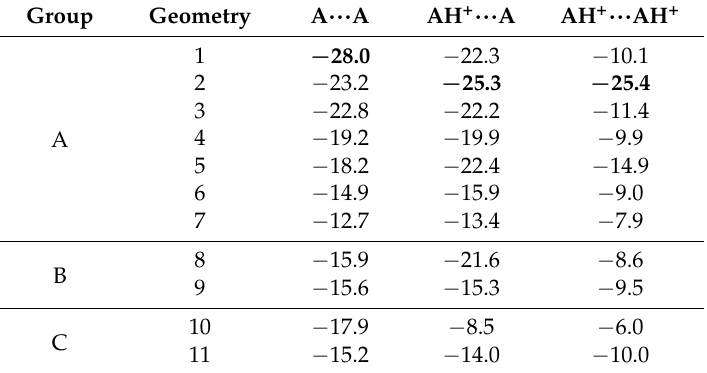
Table 2. Self-association energy (kcal · mol − 1 ) of PA1, according to the charge state (A ··· A, AH + ··· A and AH + ··· AH + ) of the two partners and according to the geometries of the different association complexes gathered in terms of structural similarities as three different groups (A, B and C). The association energies of the most stable conformers (for the three charged forms) are highlighted in bold.